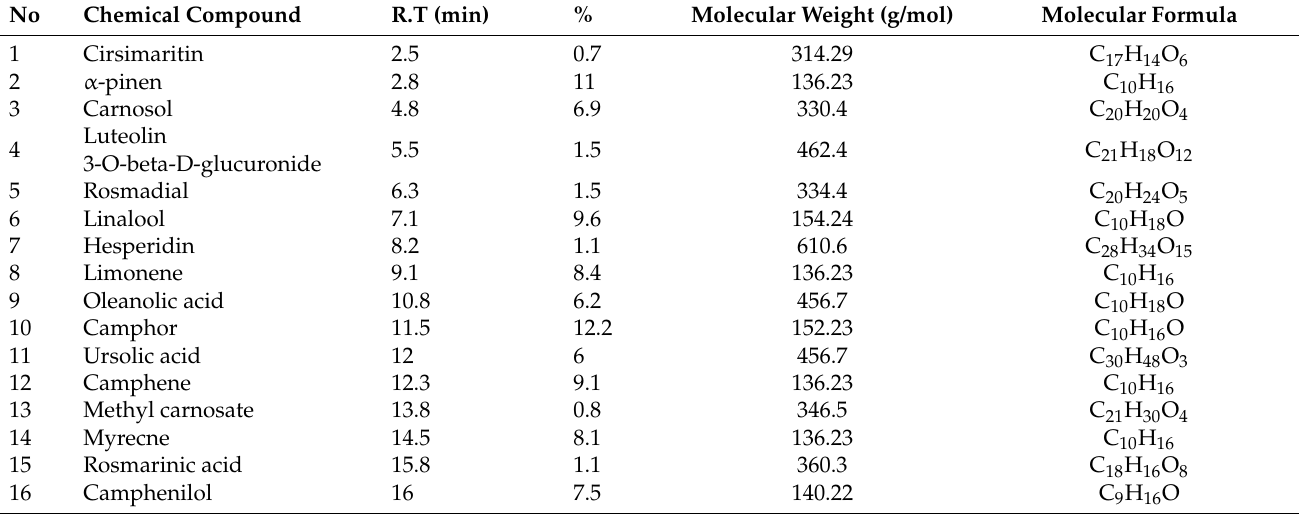
Table 6. Tentative identification of chemical constituents in the R. officinalis extract was obtained by using DES3: